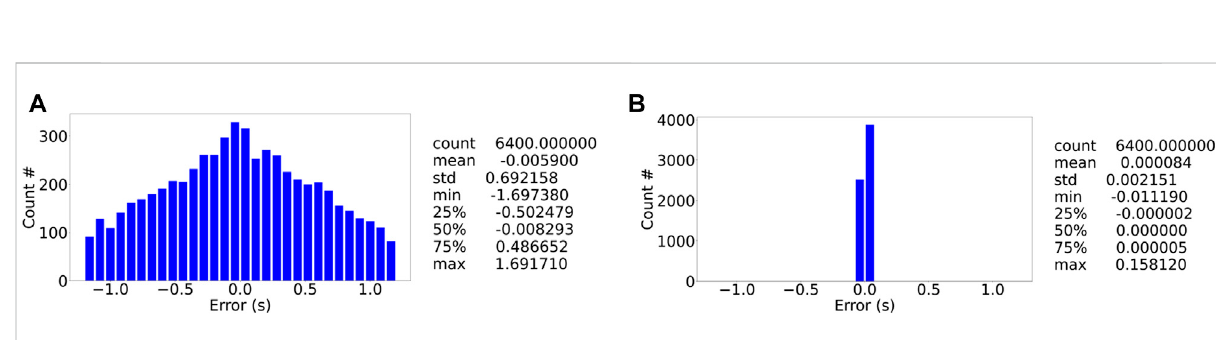
FIGURE 6 Histogram of the travel-time difference between the true and initial travel-time shift inverted by ML-mis fi t (A) before training and (B) after